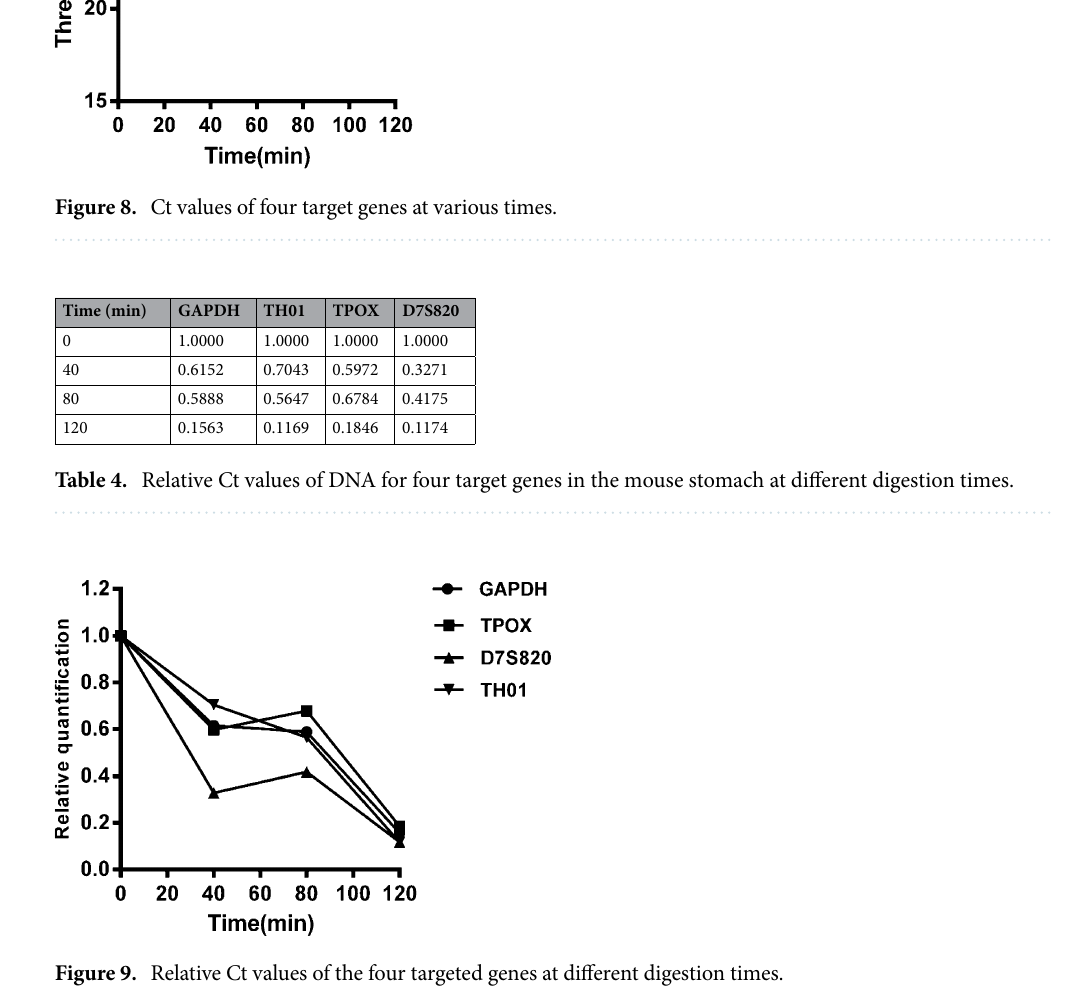
Figure 9. Relative Ct values of the four targeted genes at different digestion